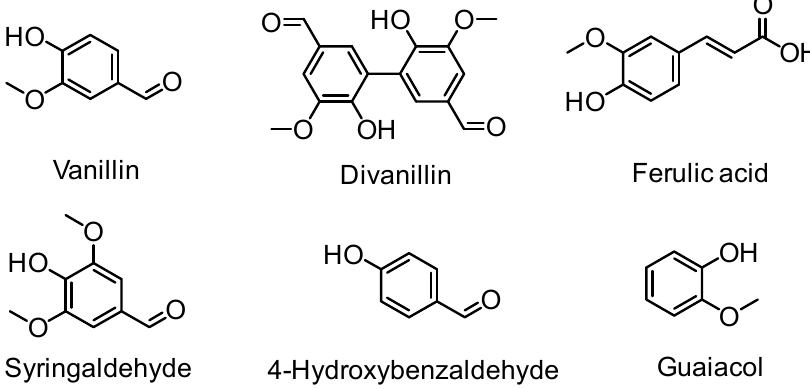
Figure 8. Lignin-derived renewable monomer precursors.